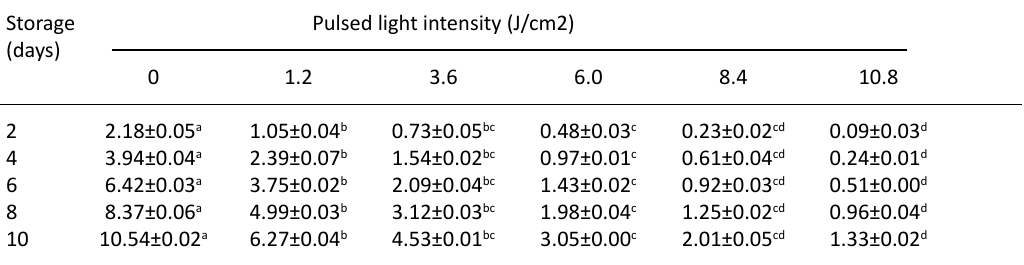
table 3. Weight attrition (%) of Chinese kale affected by pulsed light intensity (J/cm 2 )